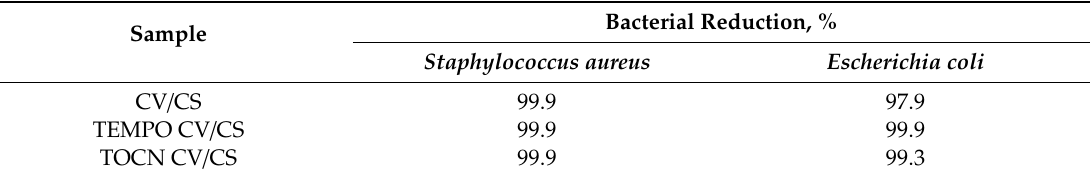
Table 3. The bacterial reduction of chitosan functionalized viscose